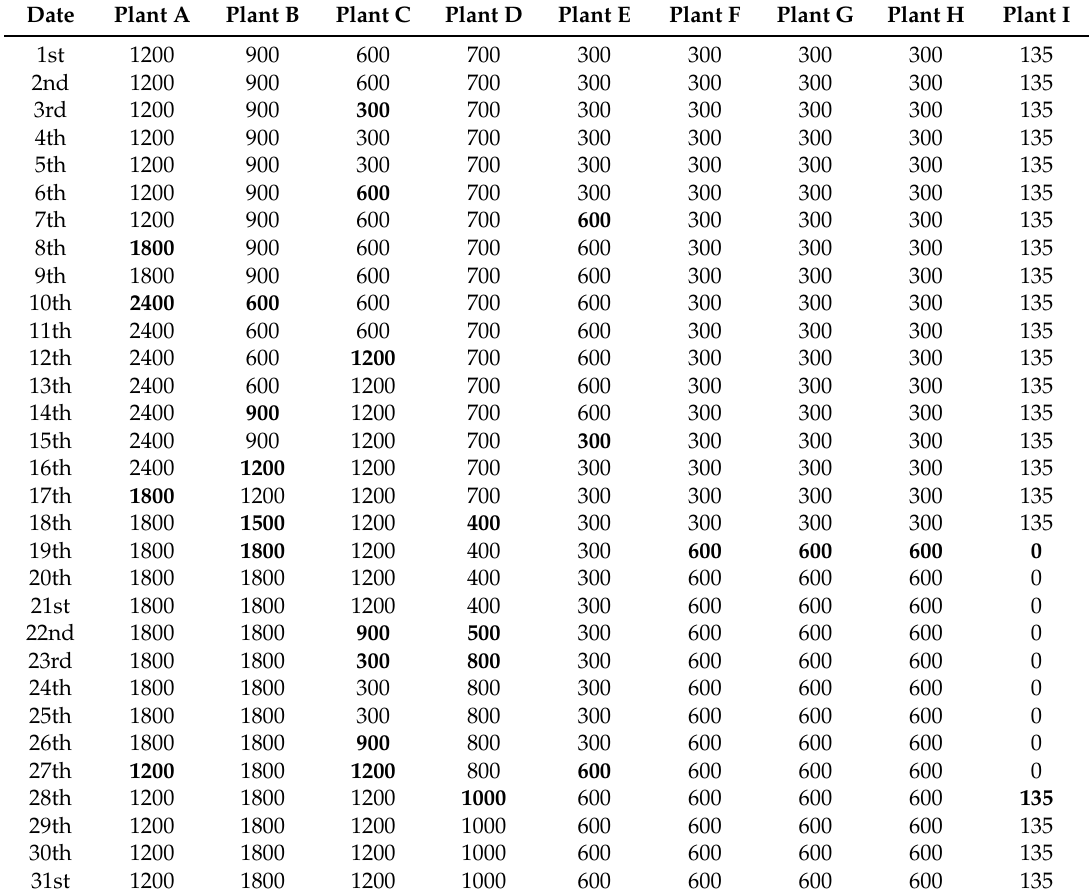
Table 3. Results of generation requirements for plants in October (MW).